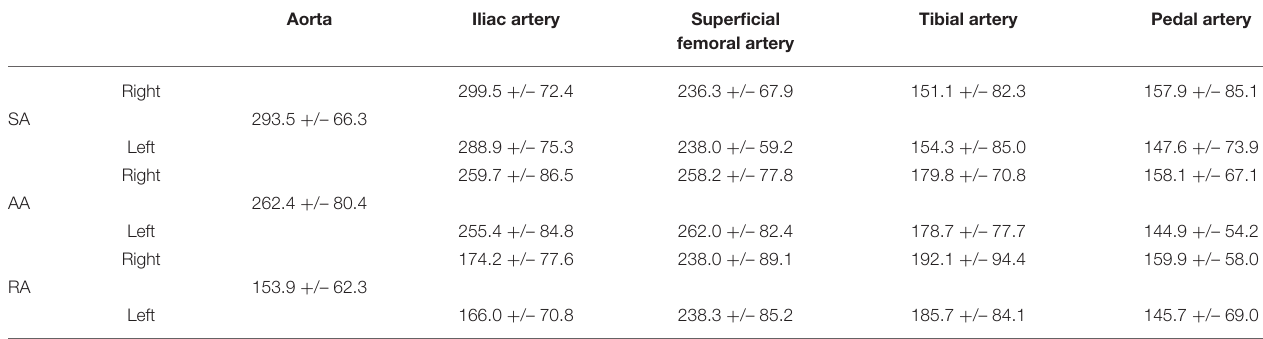
TABLE 2 | Mean attenuation at each level of interest [HU] + /– SD in the whole